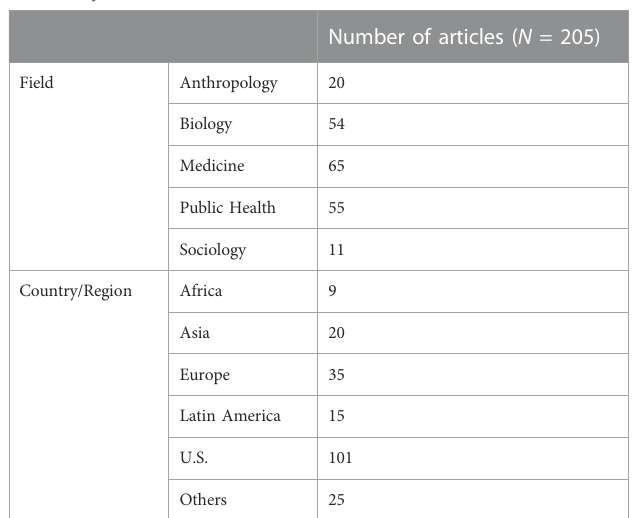
TABLE 1 Field and Country/Region of fi rst author ’ s primary af fi liation of the articles in our corpus. The countries within the “ Others ” category are Australia, Canada, New Zealand, Jamaica and Suriname. The US was not aggregated into a region because of the country ’ s dominance in the discourse around